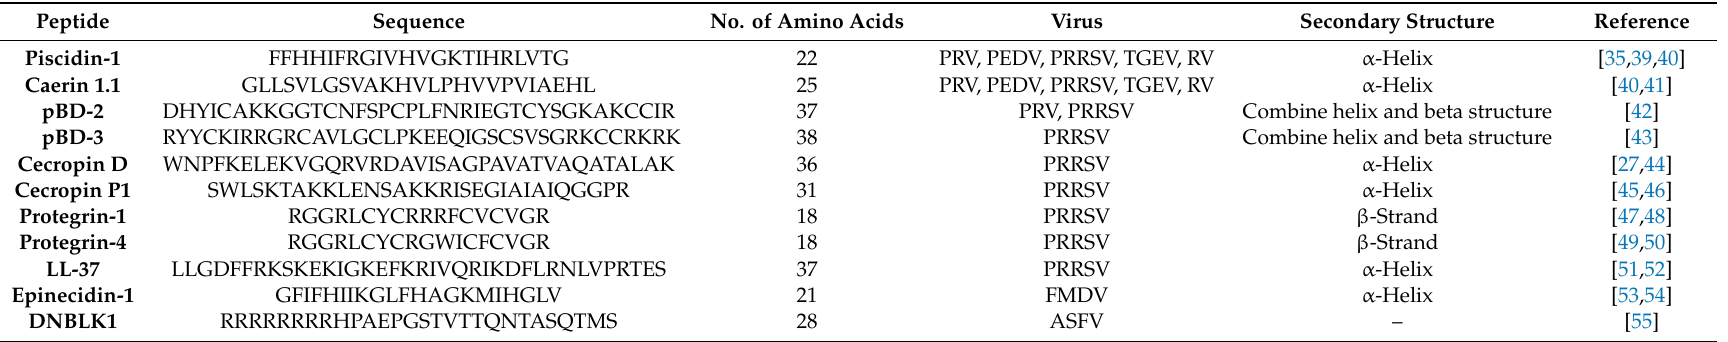
Table 1. Antimicrobial peptides and